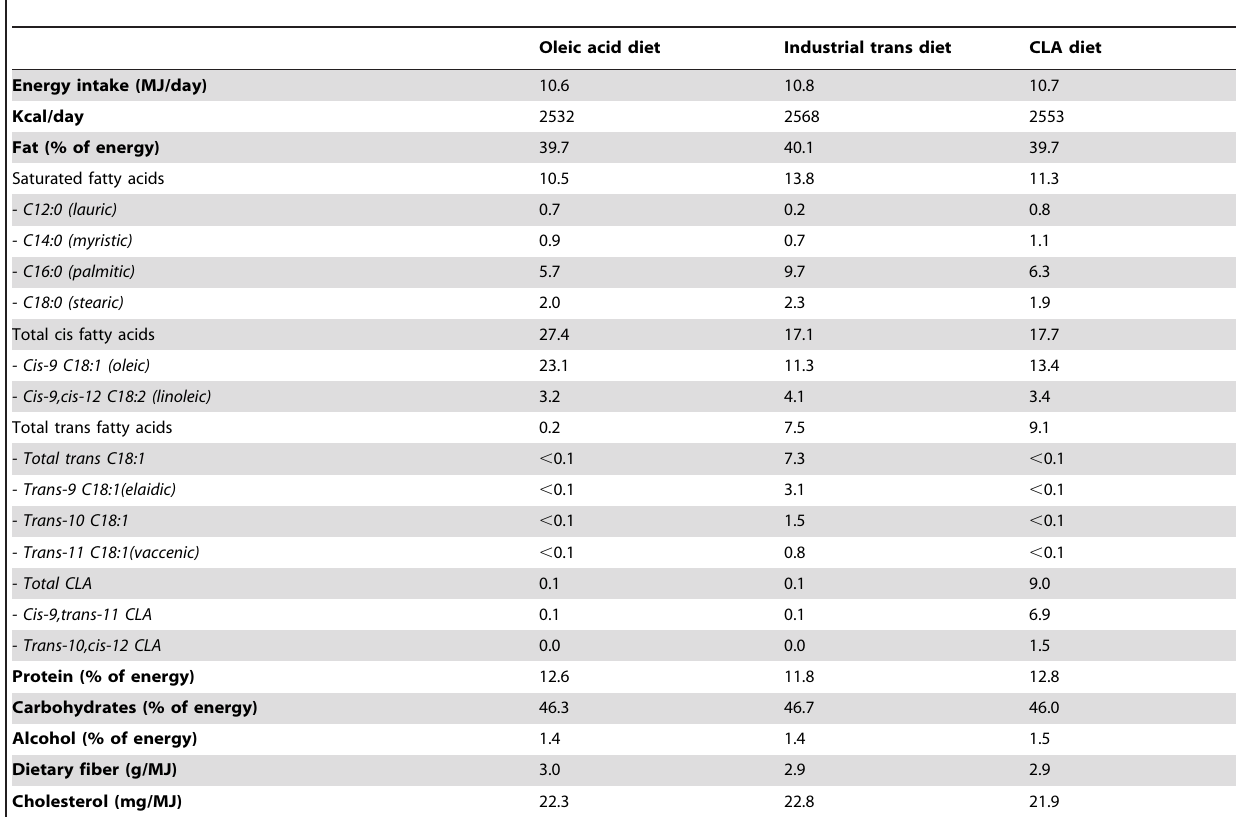
Table 3. Mean daily intakes of energy and nutrients according to chemical analysis of duplicates of the diets. 1